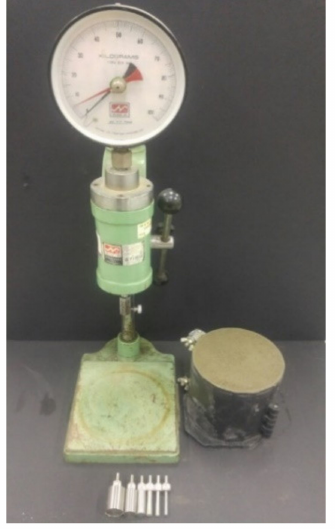
Figure 3. Test setup for set time